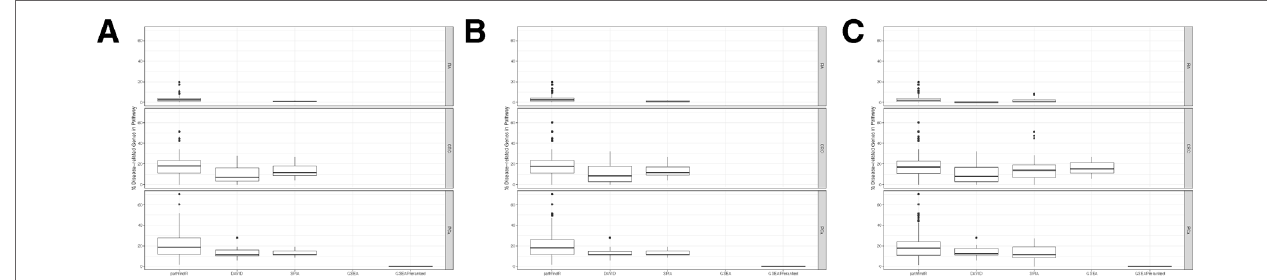
FIGURE 5 | Distributions of disease-associated genes in the enriched pathways. Boxplots displaying the distributions of the percentages of disease-related genes in the pathways found to be enriched by pathfindR, Database for Annotation, Visualization and Integrated Discovery (DAVID), Signaling Pathway Impact Analysis (SPIA), Gene Set Enrichment Analysis (GSEA), and GSEAPreranked in the datasets rheumatoid arthritis (RA), colorectal cancer (CRC), and prostate cancer (PCa). No boxplot for a tool in a particular dataset indicates that the given tool did not identify any enriched pathways in the given dataset. (A) Boxplots for all the results filtered for adjusted-p ≤ 0.05. (B) Boxplots for all the results filtered for adjusted-p ≤ 0.1. (C) Boxplots for all the results filtered for adjusted-p ≤ 0.25.